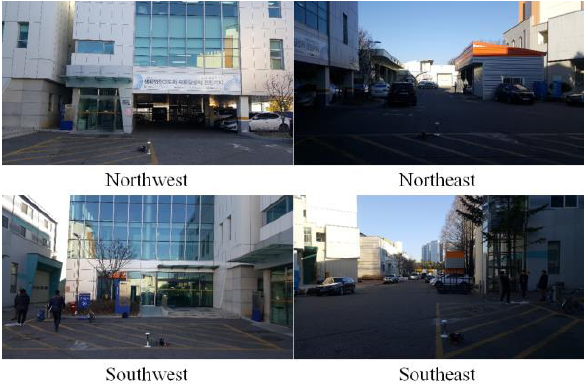
Figure 7. Landscape for each direction of target